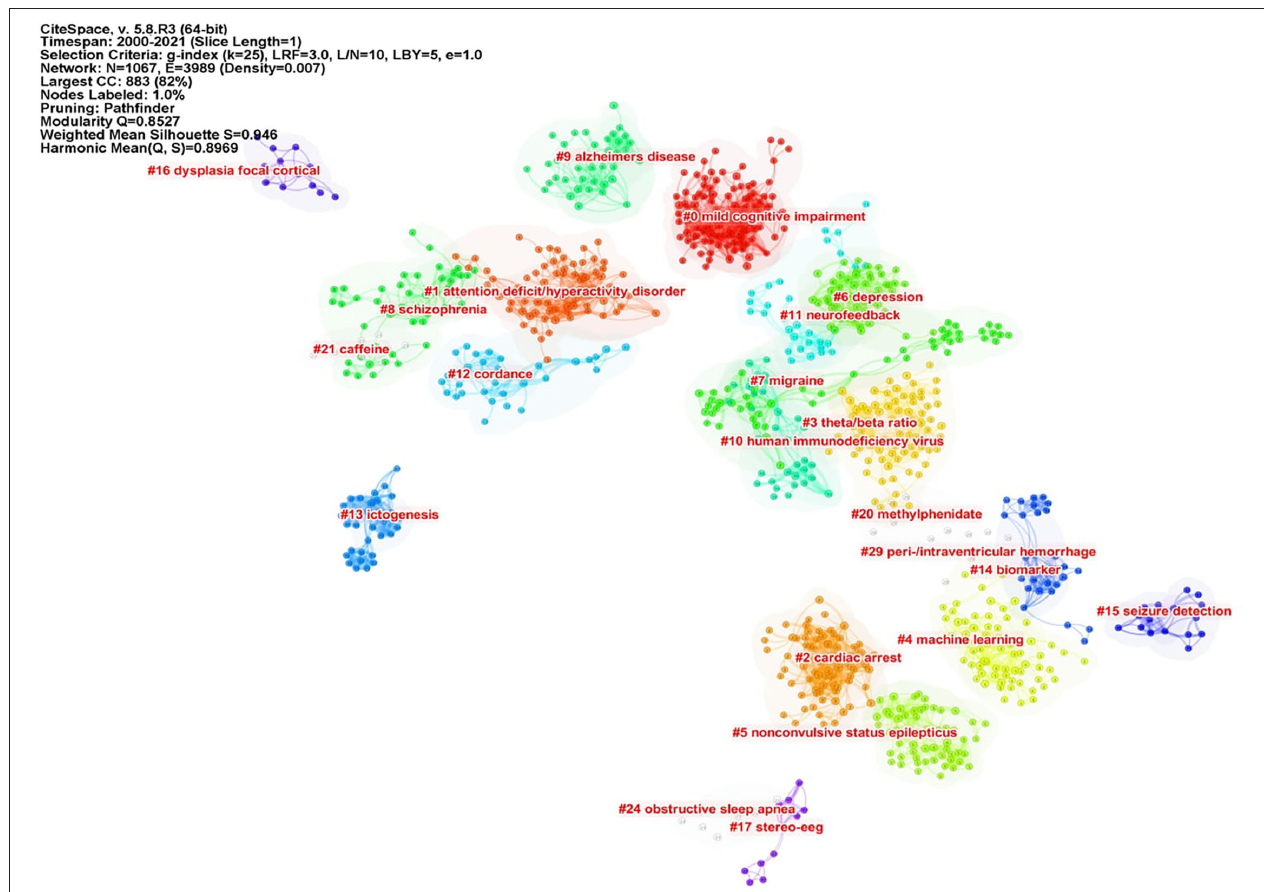
FIGURE 6 | Cluster analysis of co-cited